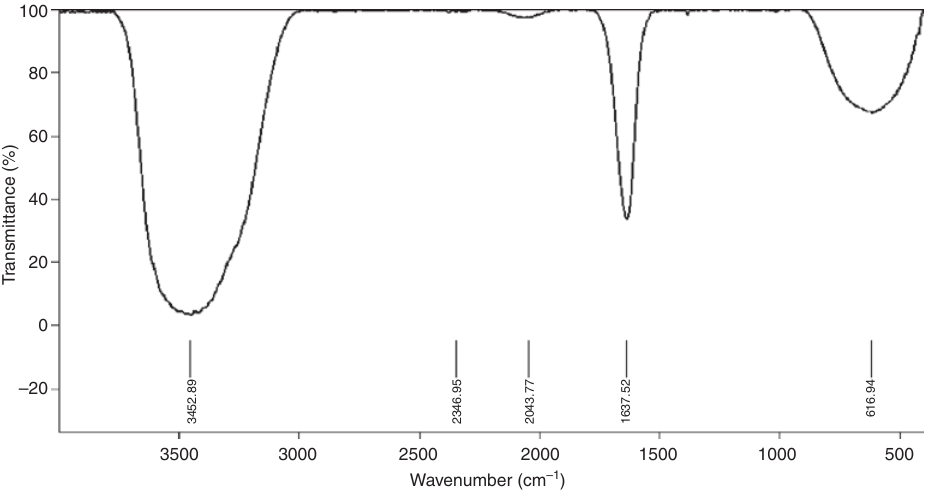
Figure 1: FT-IR spectrum of Pelargonium/Geranium leaf